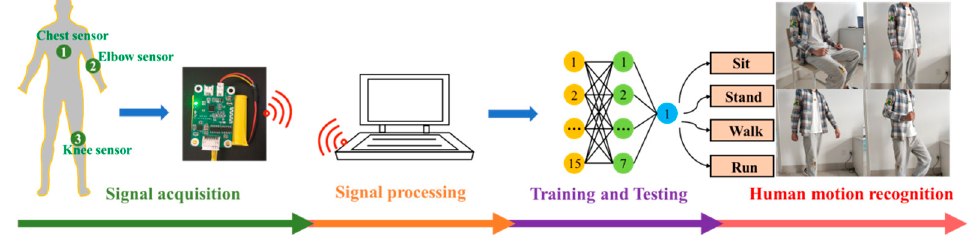
Figure 16. Human motion state recognition system. Table 2. Test results of the neural network model.